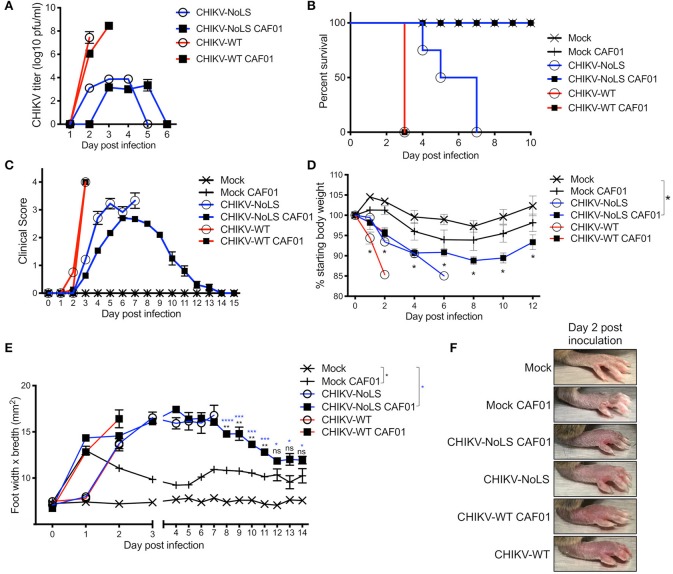
Inoculation with CHIKV-NoLS CAF01 elicits de novo viral particle production and disease in AG129 mice. AG129 mice were inoculated with viable virus/vaccine particles (104 pfu CHIKV-WT or CHIKV-NoLS) or CAF01 delivered RNA (2 μg CHIKV-WT or CHIKV-NoLS RNA complexed with 0.3 mg CAF01) in the ventral/lateral side of the right foot. Mock inoculated mice received 20 μl VPSFM media or VPSFM media containing 0.3 mg CAF01. (A) Serum was collected on days 1–6 post inoculation and virus titrated by plaque assay. Survival curves were constructed (B) as mice were monitored for the development of disease signs (C) and changes in weight (D) every 24 h. Disease signs in inoculated AG129 mice were scored on a scale of 0–4 where 4 is humane endpoint. (E,F) CHIKV-induced footpad swelling was assessed by measuring the height and width of the perimetatarsal area of the foot, using Kincrome digital vernier calipers. Each symbol represents the mean ± standard error from five to six mice. Statistical analysis was performed by non-parametric Mann–Whitney t-test between the groups indicated on the figure legend by the bar and *color. ns, not significant,*P < 0.05, **P < 0.005, ***P < 0.001, and ****P < 0.0001.